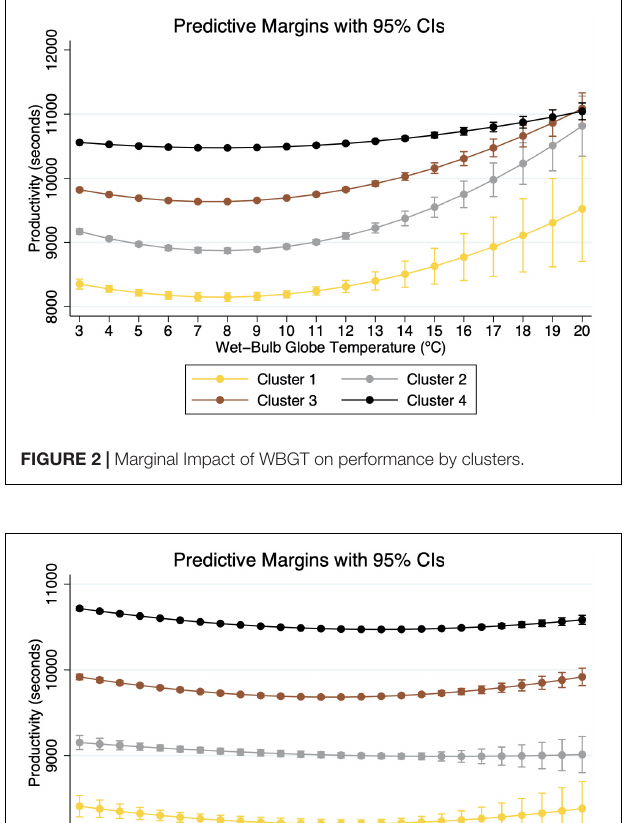
TABLE 1 | Effects of WBGT and UTCI on performance by clusters of runners.